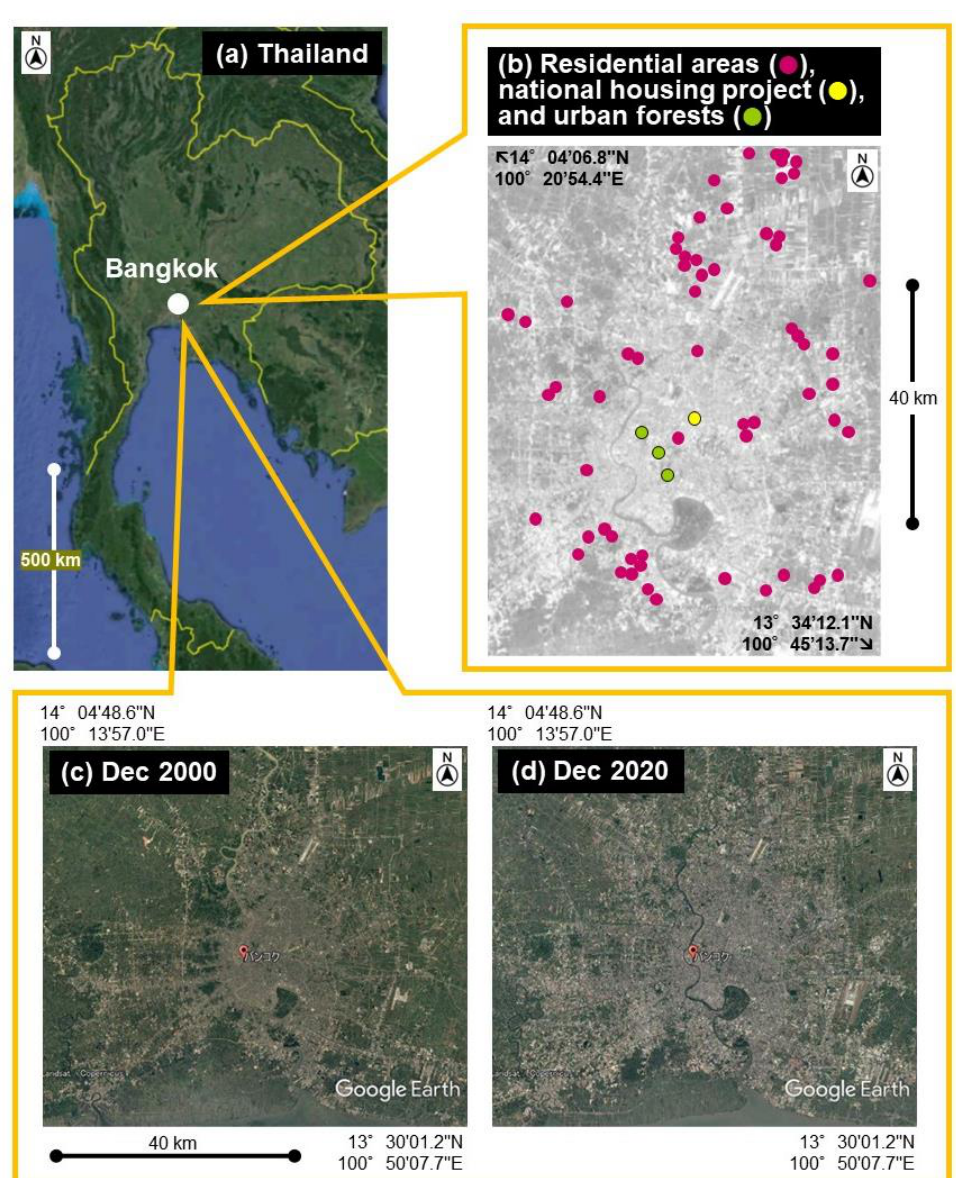
Figure 1. Maps of Thailand (a), positions of the Bangkok residential areas investigated in this study (b), and true-color aerial images of Bangkok and surrounding provinces in 2000 (c) and 2020